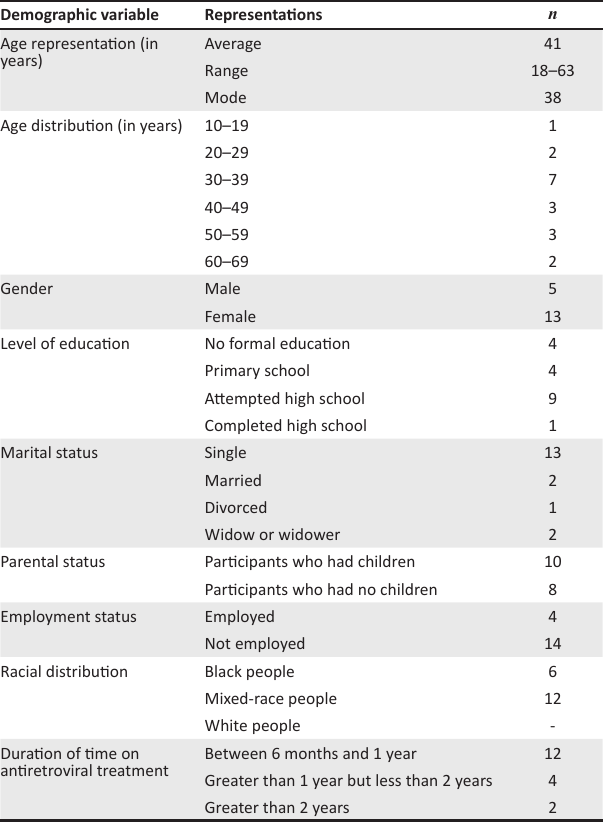
TABLE 1: Demographic characteristics of the participants. Demographic